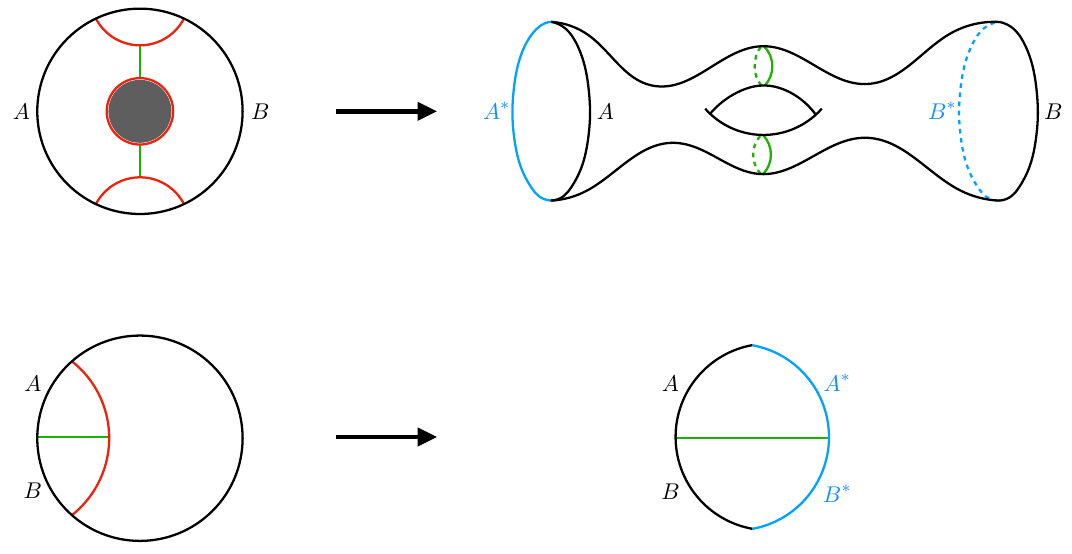
Figure 2 . Doubling W AB and gluing along m ( AB ) produces the geometry that is holographically dual to the canonical purification of ρ AB . [Top] Two disjoint boundary regions for a state that con- tains a black hole in the bulk. Γ AB and its CPT conjugate join up to form two disjoint closed loops that are together homologous to AA ∗ . [Bottom] Two boundary regions that share a boundary. Γ